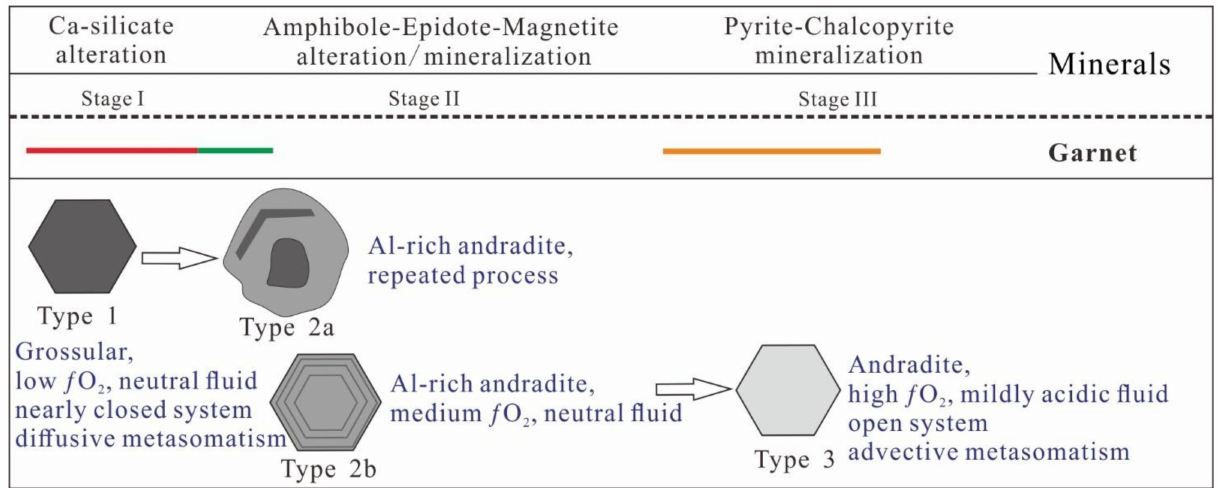
Figure 15. The growth sequence of different generation garnets from various mineralization stages in the Laoshankou